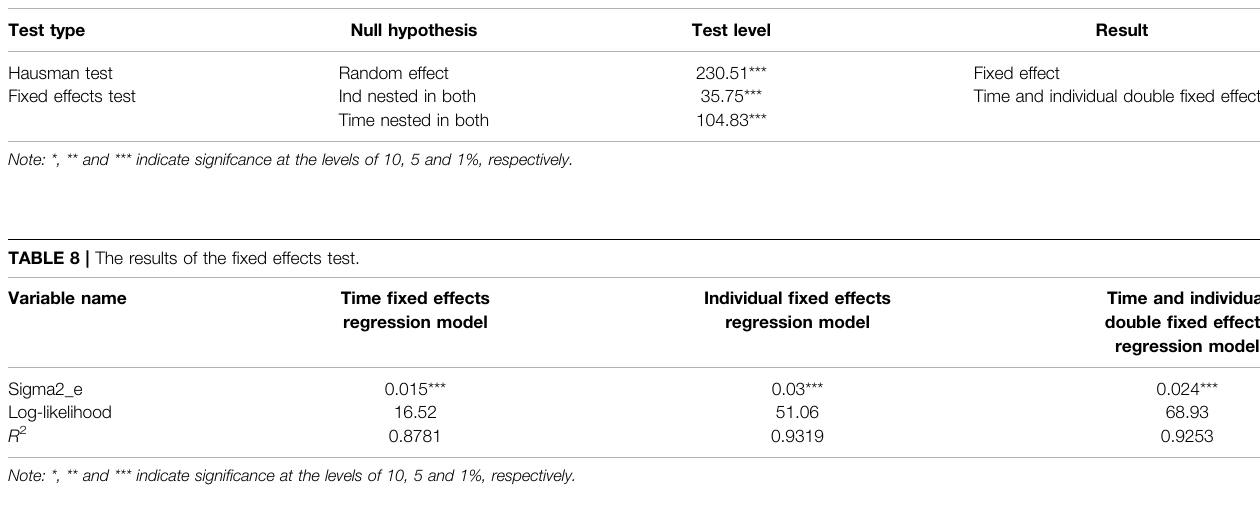
TABLE 9 | The results of the test.